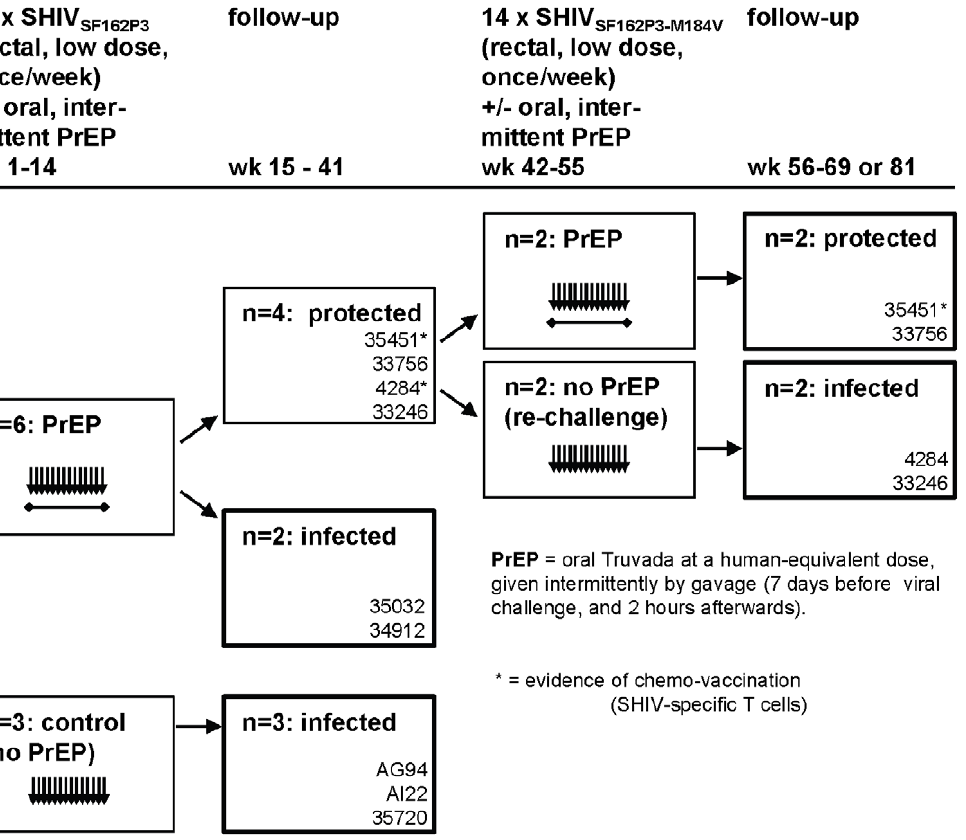
Figure 1. Experimental Design. SHIV-specific T cells were measured during the indicated experimental procedures. Arrows indicate repeated viral exposures, horizontal lines depict intermittent, oral PrEP. PrEP consisted of human-equivalent doses of oral Truvada. Each virus exposure was flanked by a waning drug dose of 7 days prior, and one drug dose administered 2 hours after exposure, as a model for intermittent PrEP use in humans. Bolded rectangles highlight final outcomes of SHIV challenges. Numbers in lower right corners refer to macaque identifications (IDs).